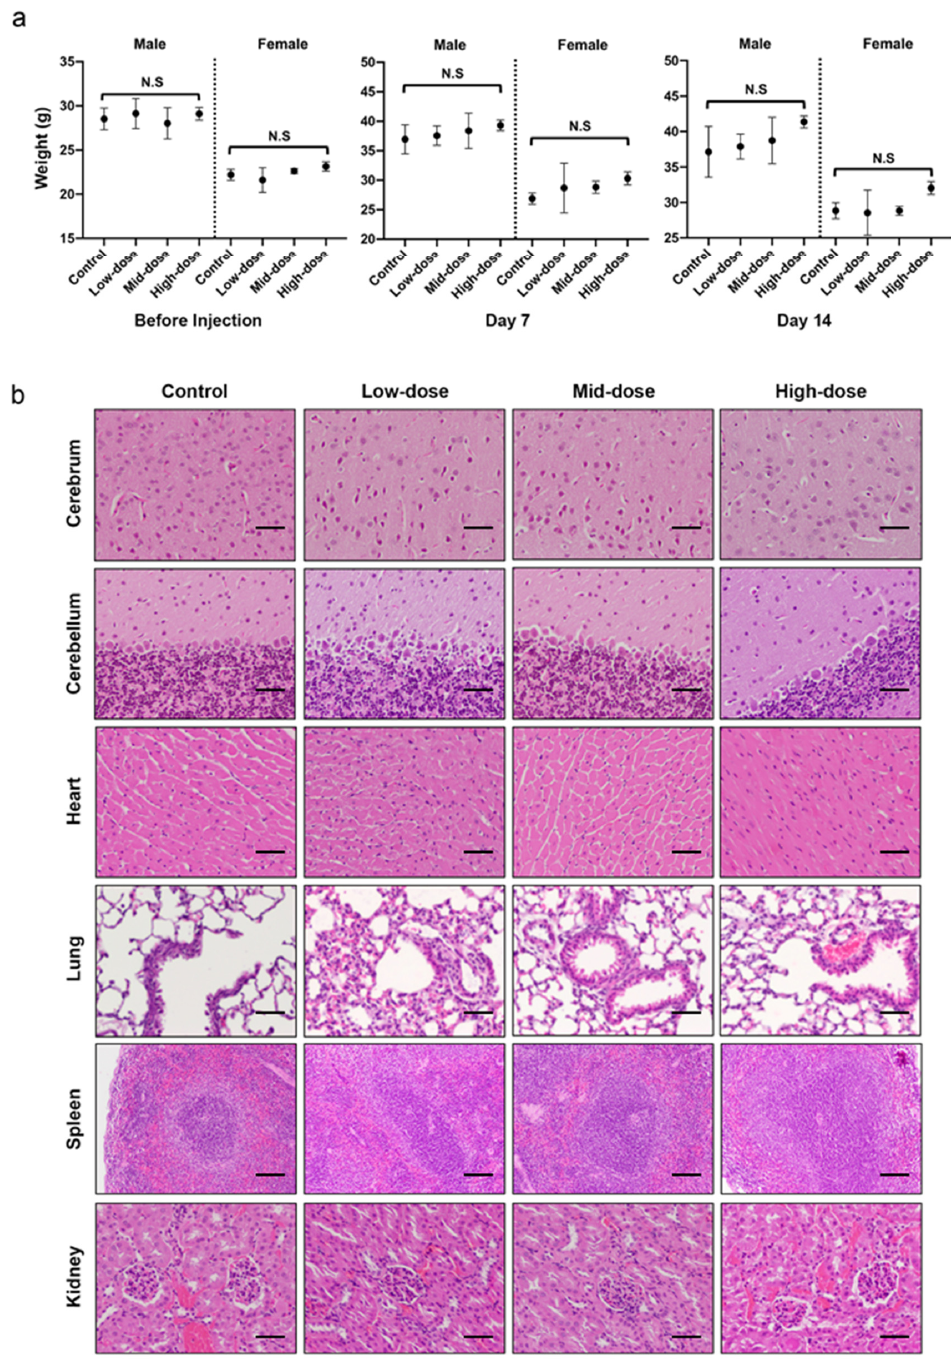
Figure 1. The use of fucoidan at the single dose of 50–275 mg kg − 1 via intraperitoneal injection is determined safe in mice. ( a ) Left panel: there was no significant difference in body weight of the males and females when they were randomly assigned to each group before the injection. Middle panel: The body weight of the mice was not affected 14 days after the exposure to a single dose of Fucoidan. Right panel: Low-, mid- and high-dose Fucoidan did not affect the body weight of the mice at the end point of the toxicity test. ( b ) Representative microscopic images depict no observable impact of fucoidan to the brain, heart, lung, spleen, and kidney. All data are shown in means ± s.d. Exact p -values are reported in text. Scale bar = 50 µ m for cerebrum, cerebellum, heart, lung, and kidney = 100 µ m for